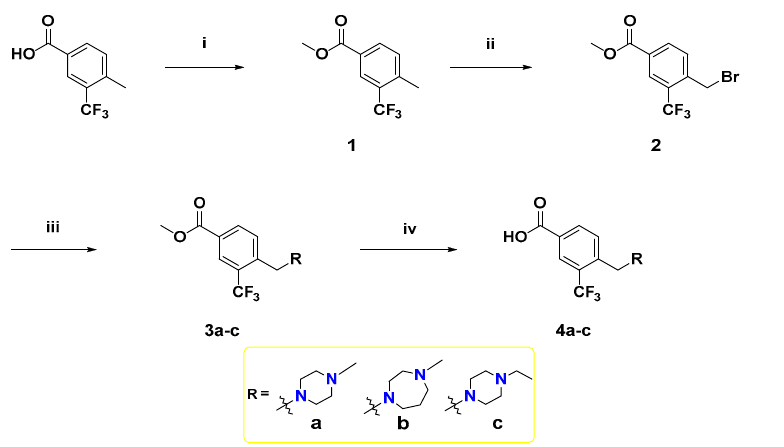
Figure 3. Structural modifications of lead compound VII for the discovery of novel RAF kinase in-